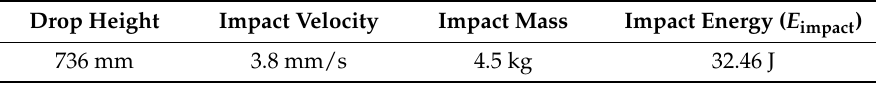
Table 3. Impact characteristic of the drop-weight